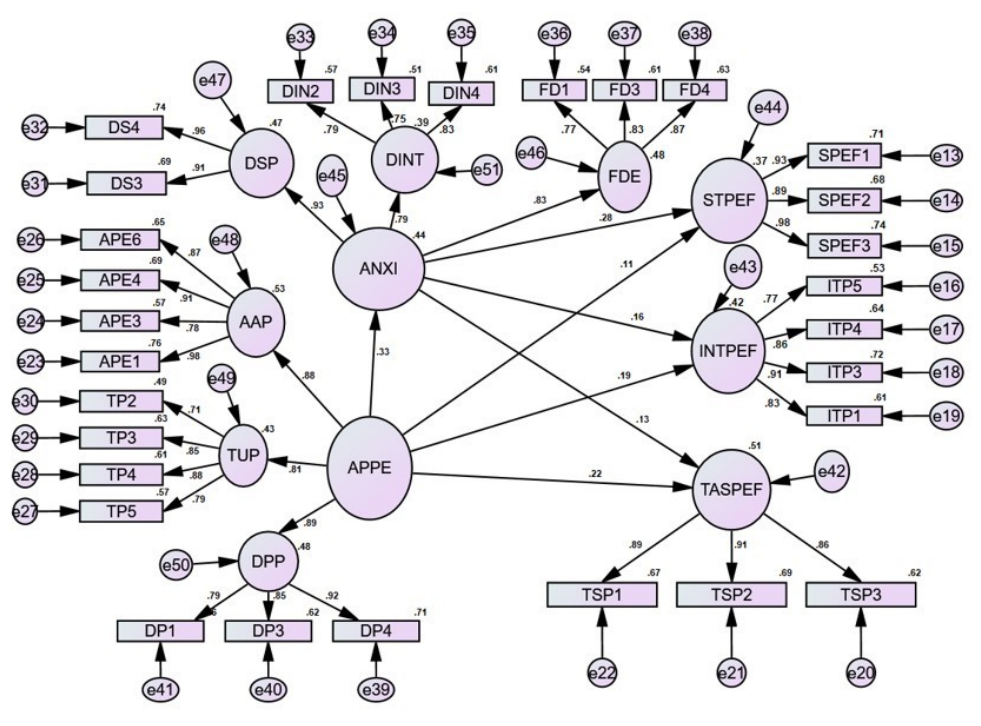
Figure 2. Structural equation